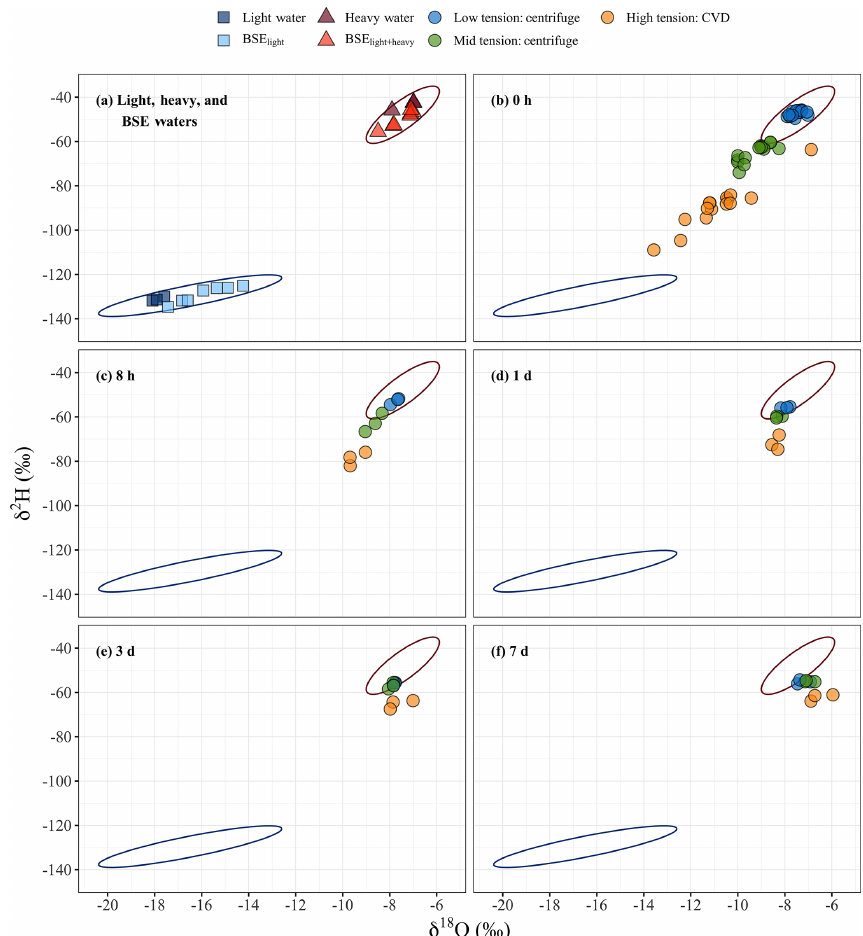
Figure 4. Isotopic values of water samples in dual-isotope space, δ 2 H VSMOW (‰) vs. δ 18 O VSMOW (‰). (a) Light, heavy, and BSE (bulk sample extraction) waters with 95% confidence interval ellipses generated by pooled data of light, heavy, and BSE waters, as the pooled groups were found to be not significantly different with pairwise MANOVA (Table A1); the blue ellipse represent BSE light and light water, and the red ellipse represent BSE light + heavy and heavy water. (b–f) Waters extracted at low, mid, and high tension for each equilibration time point. The 95% confidence interval ellipses from (a) are included in (b–f) for